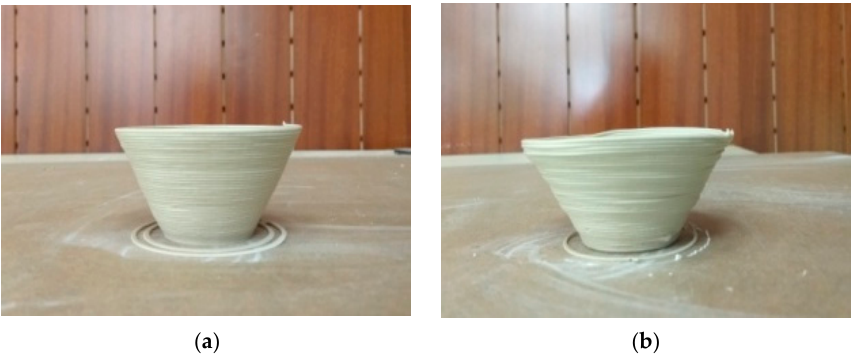
Figure 11. Conical thin-walled benchmark parts with in situ hot air flow drying: ( a ) cone angle as 30° and ( b ) cone angle as 35°.